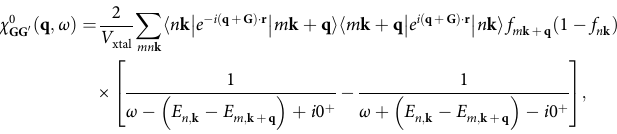
r ð Þj j 2 to the maximum intensity of the tot